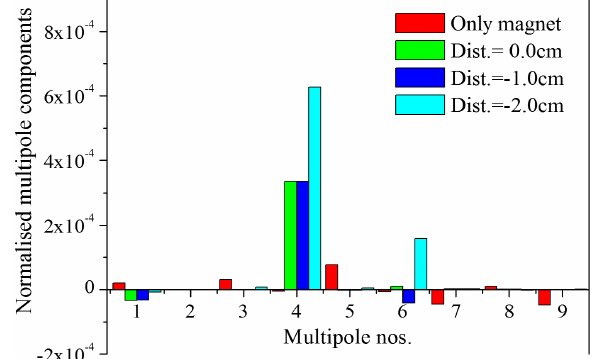
FIG. 14. Multipole components, integrated over the magnet, R normalized with the quadrupole component in the case of a g:dl in T magnet without an end tube and when the tubes are placed at 0, − 1 , and − 2 cm from the edge of the magnet.